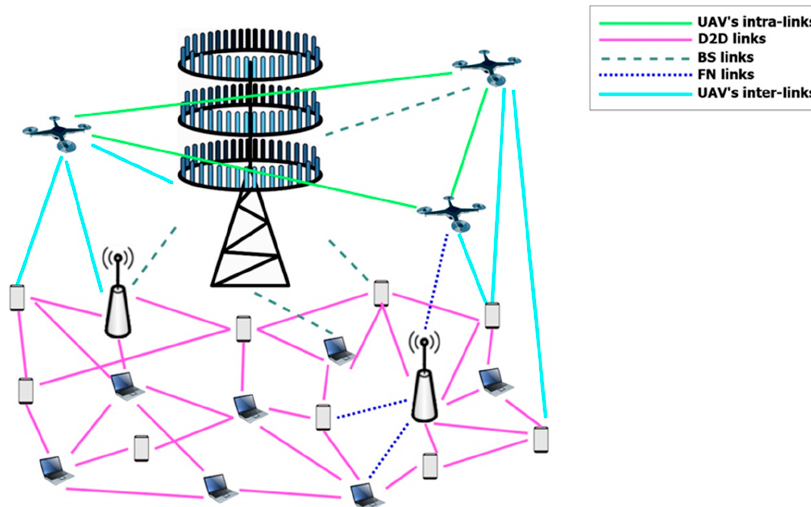
Figure 1. A fifth generation (5G) network topology with dynamic network configuration.